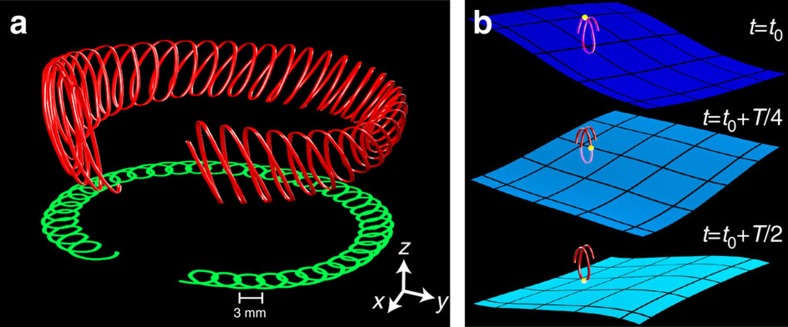
Rotating drift mechanism.(a) Experimentally measured 3D trajectory (red) of a surface particle drifting within a unit cell and its projection on the horizontal plane (green) (experiments, f=ω/2π=3.9 Hz, λ=104 mm, H=2.5 mm). (b) Positions of an imaging particle (yellow dot) on the 3D trajectory at three consecutive moments in time within half a wave period. See Supplementary Movie 2 for details. Blue surfaces show the rotation of the liquid surface measured simultaneously with the particle position.